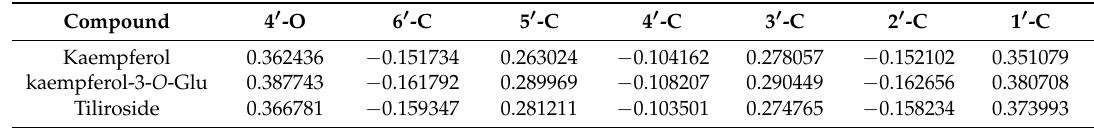
Table 5. The C-ring’s spin density of kaempferol, kaempferol-3- O -Glu and tiliroside.